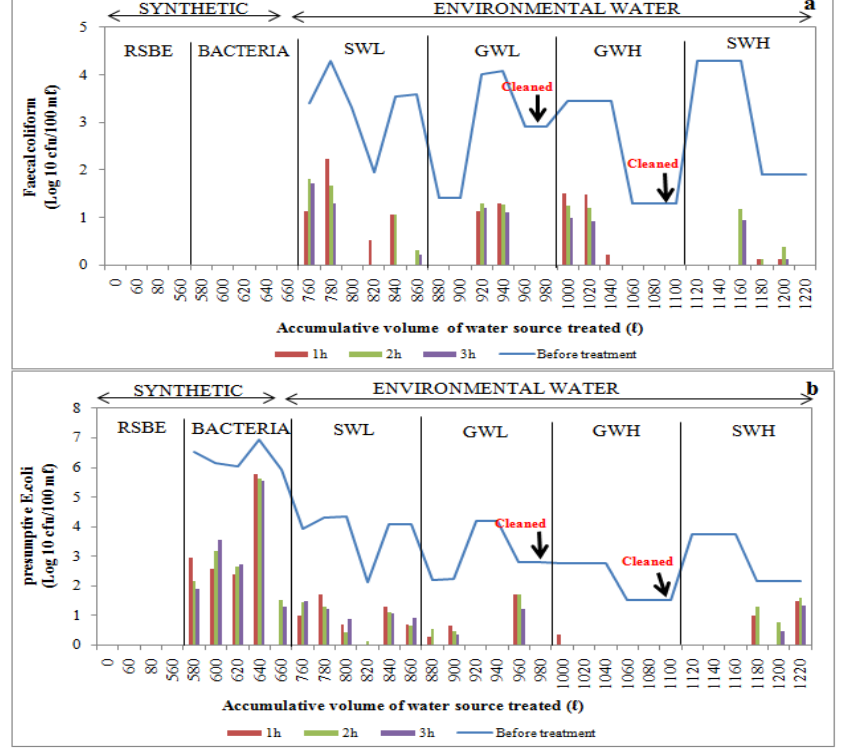
Figure 9. Log faecal coliform ( a ) and E. coli ( b ) concentrations in biosand filter-sand 10 (BSF-S) before and after treatment of over 1220 L of source water: synthetic water and environmental water samples (SWL, GWL, GWH and SWH). RSBE is the running of the system before the experiment, using deionised